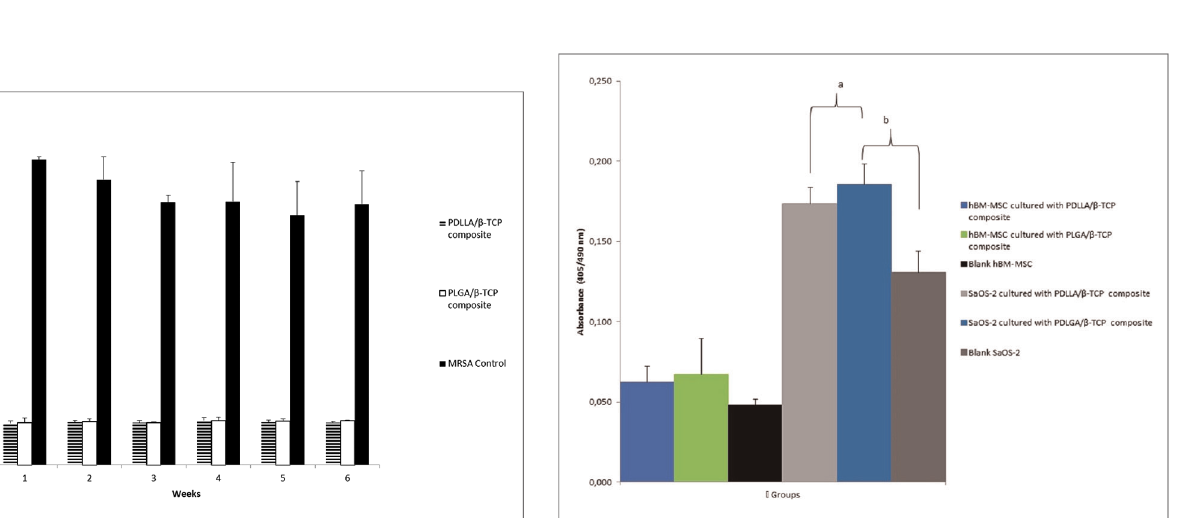
FIGURE 7 | Alkaline phosphatase (ALP) activity of the groups at day 21 according to their absorbances at 405 nm. PDLLA, poly( D , L -lactide); PLGA, poly( D , L -lactide-co-glycolide); β -TCP, beta-tricalcium phosphate; SaOS-2, osteosarcoma cell; hBM-MSC, human bone marrow-derived mesenchymal stem